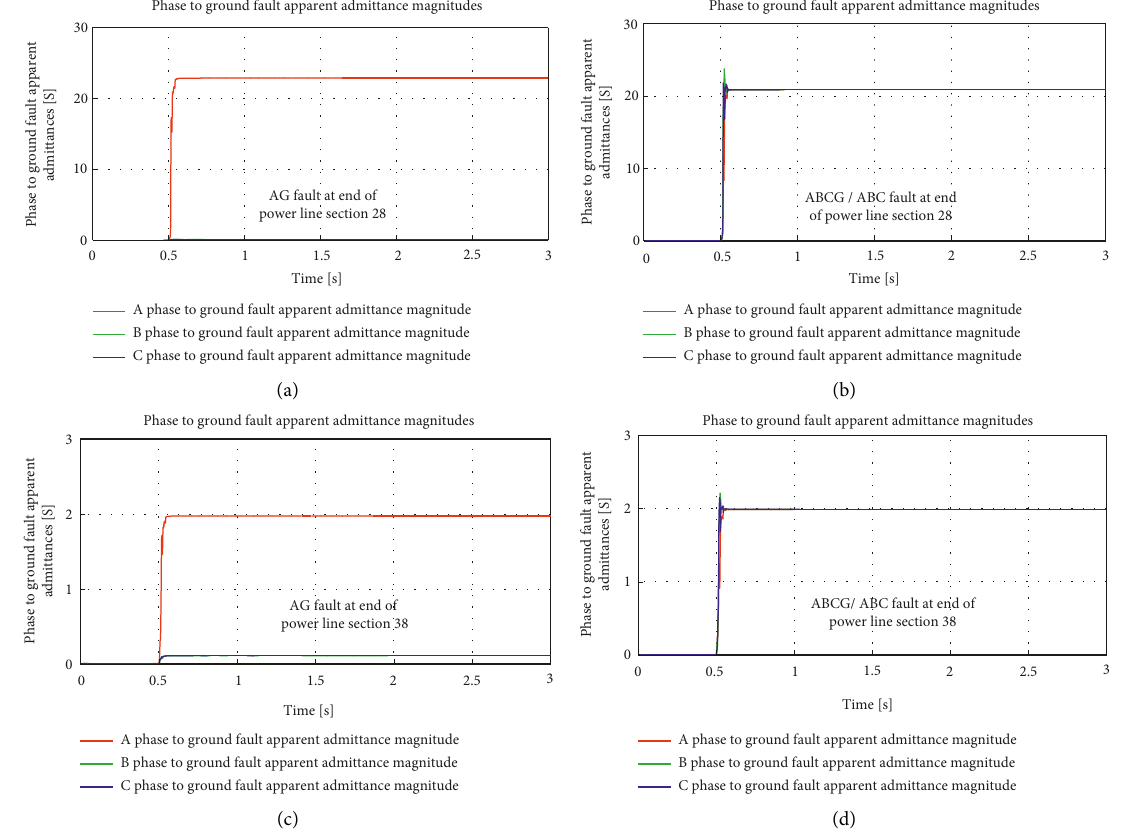
Figure 14: Measured PGFA admittance magnitudes for the grid simulated AG and ABCG/ABC electrical faults at end of the power line section (a, b) 28 and (c, d) 38 with CT/PT saturated Table 8: Comparison of the methods to detect the types of electrical faults. Methods Algorithms Computationally efficient distance relay for power transmission lines [4, 15]. Electrical fault finding for protective relays in power transmission lines [4, 16]. PGFA admittances with phase/ground boundaries for power lines.